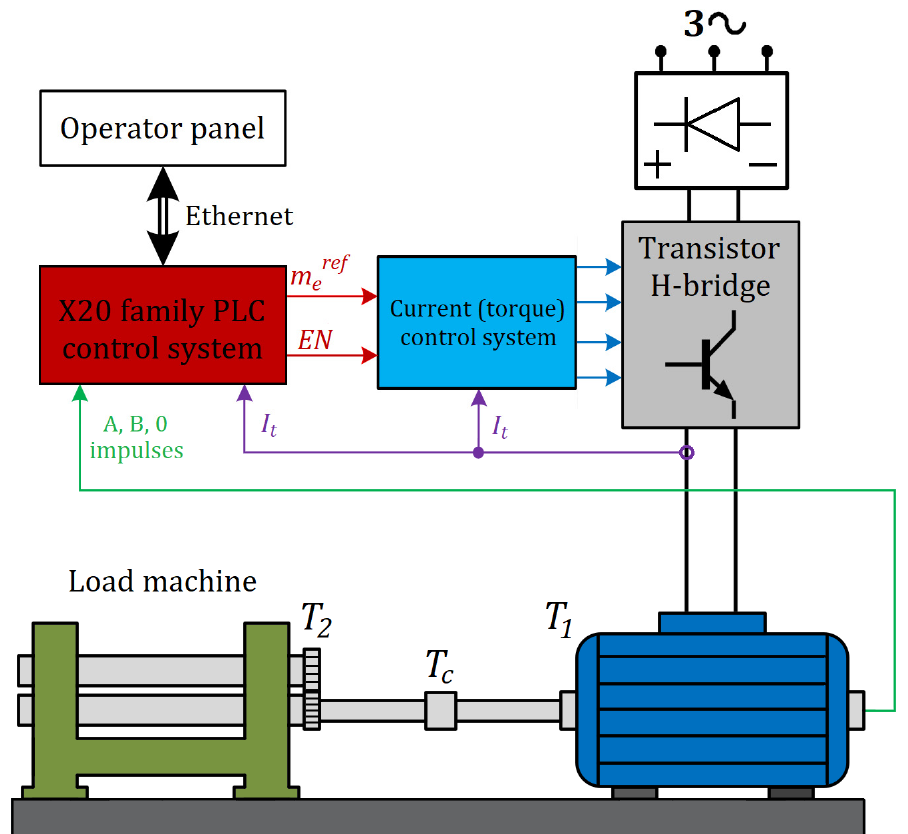
Figure 2. Proposed structure for industrial implementation.